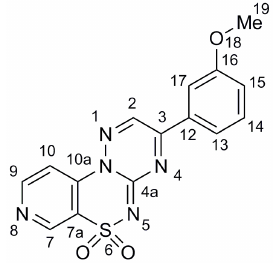
Figure 4. The structure of 3-(3-methoxyphenyl)pyrido[4,3- e ][1,2,4]triazino[3,2- c ][1,2,4]thiadiazine 6,6-dioxide 25 ; the atom numbers are correlated with the NMR results.